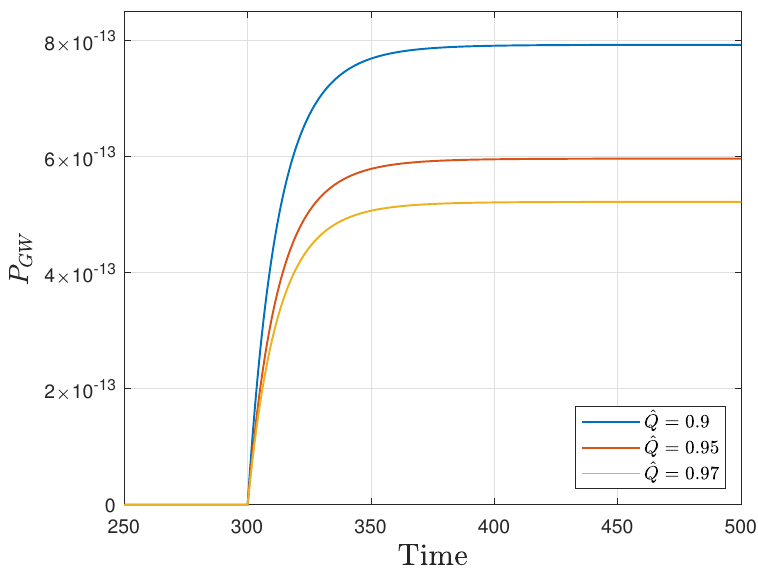
( 1 ) Figure 3. Energy carried by the gravitational wave, Ψ , according to Equation (126), for the values 4 ˆ Q = 0.9,0.95,0.97 proportional to the charge of the black hole. Our system of equations allows for a purely electromagnetic/gravitational response (encoded in the function χ ). Indeed, for the l = 1 case, which corresponds to a dipole angu- lar distribution, there is no gravitational response, as the gravitational waves occur starting from the quadrupolar angular distribution [31], but there might be an electromagnetic one.